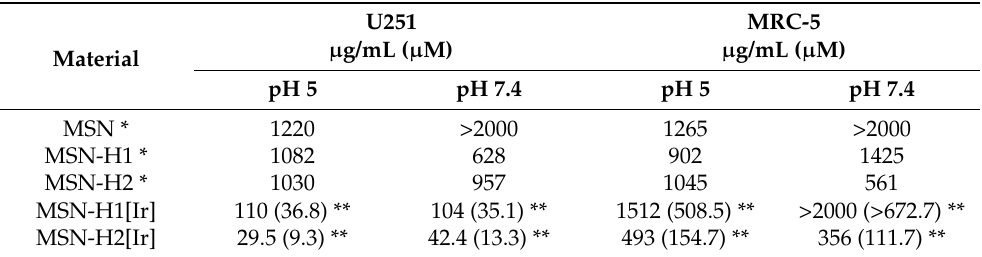
Figure 5. ( a ) Release profiles of Ir(III) complex from MSN-H1[Ir] ( • ) and MSN-H2[Ir] ( (cid:78) ) in PBS buffers with pH 5.0 (red), pH 6.0 (green) and pH 7.4 (blue) for 48 h; ( b )—UV/VIS spectra of supernatants after 48 h of stirring at different pH values. Table 2. MC 50 (IC 50 ) values of the U251 and MRC-5 cells treated for 48 h after pre-incubation of materials in corresponding buffers for 24 h.